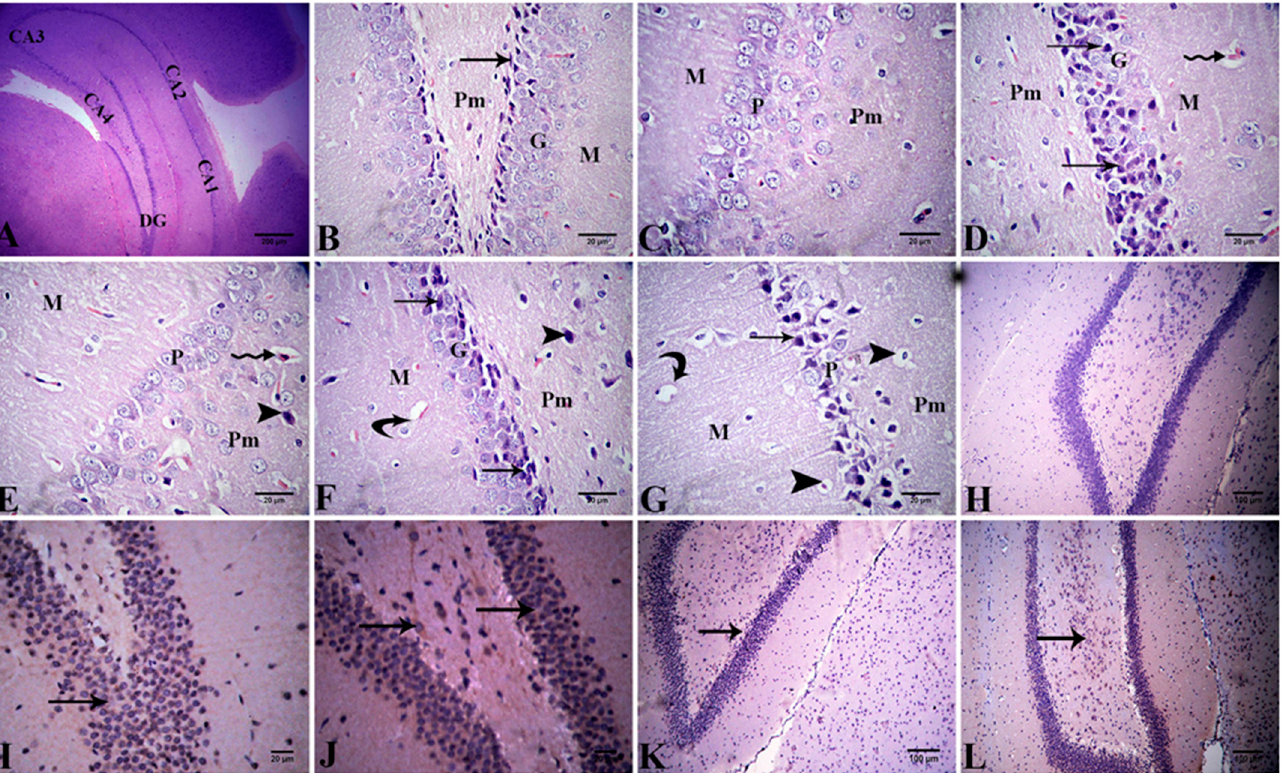
Figure 8. ( A – G ) Photomicrograph of the hippocampus tissue sections stained with H&E. CornuAmmonis (CA), dentate gyrus (DG), molecular layer (M), pyramidal layer (P), polymorphic layer (Pm), and granular layer (G) in control ( A ), and Alhagi-treated rats ( B , C ) showing normal structure of hippocampus, the subgranular zone of dentate gyrus (arrow) ( B ) and the normal arrangement of CornuAmmonisin ( C ). The lead treated-rats show necrotic neurons of granular layer of DG (arrows) and blood capillaries widening (zigzag arrow) ( D ), necrotic neuron of polymorphic layer of CornuAmmonis (arrow head) and blood capillaries widening (zigzag arrow) ( E ). The lead + Alhagi-treated rats show vacuolation of neuropil (curved arrows), necrotic neurons (arrows), and vacuolation of perineural spaces ( F , G ). ( H – L ) Photomicrograph of the hippocampus demonstrate Bcl-2 immunoexpression (arrows) as the following: negative in the negative control ( H ), moderate in the control ( I ), strong in the Alhagi-administered rats ( J ), negative to weak in the lead-intoxicated rats ( K ), and mild in the lead + Alhagi-exposed rats ( L ).